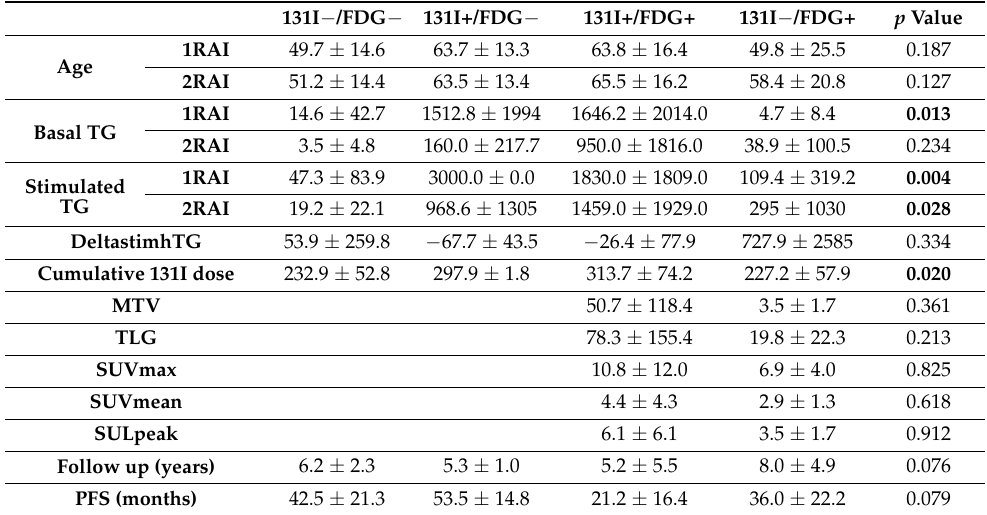
Table 3. Distribution of the means of the 131I/FDG subgroups and related variables (Kruskal– Wallis